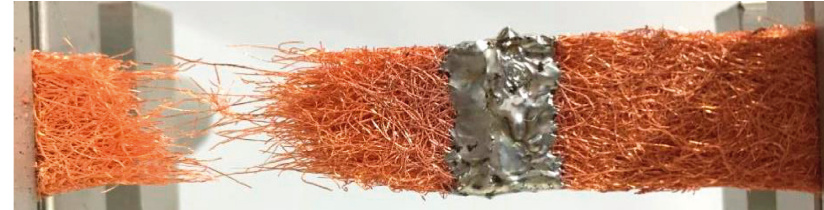
Figure 8: Tensile fracture appearance of soldered PCFSSs with the same porosity.